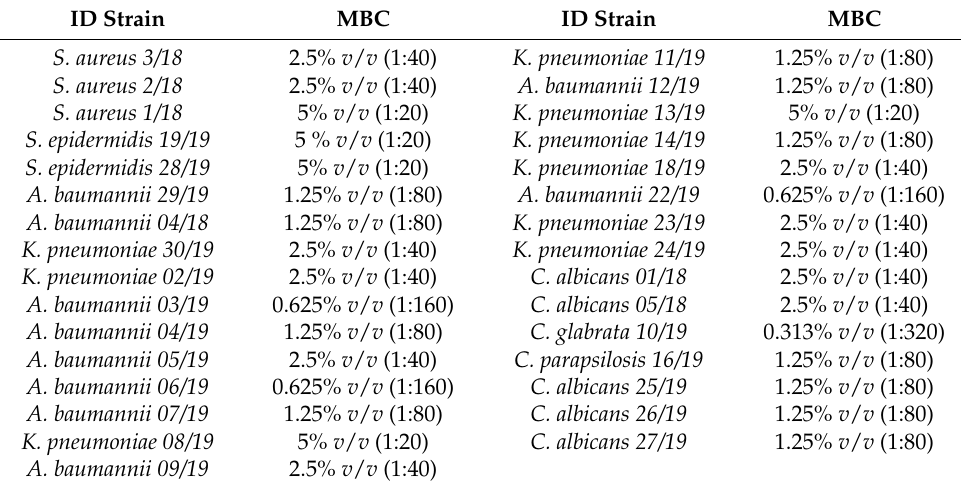
Table 3. MBC values% v / v (dilution of distilled extract of